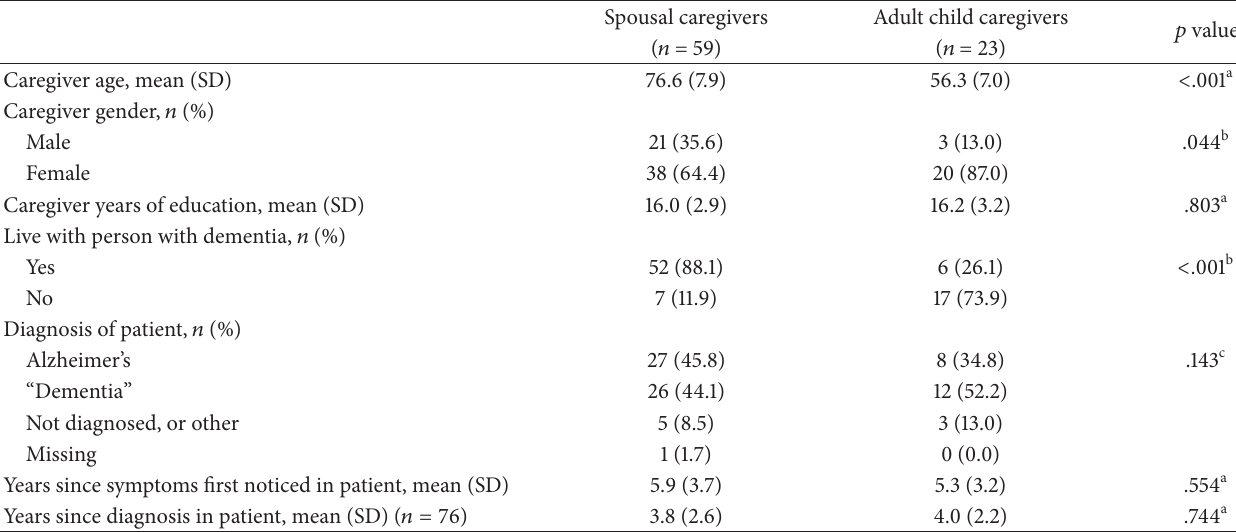
Table 1: Caregiver characteristics by caregiver type. Spousal caregivers